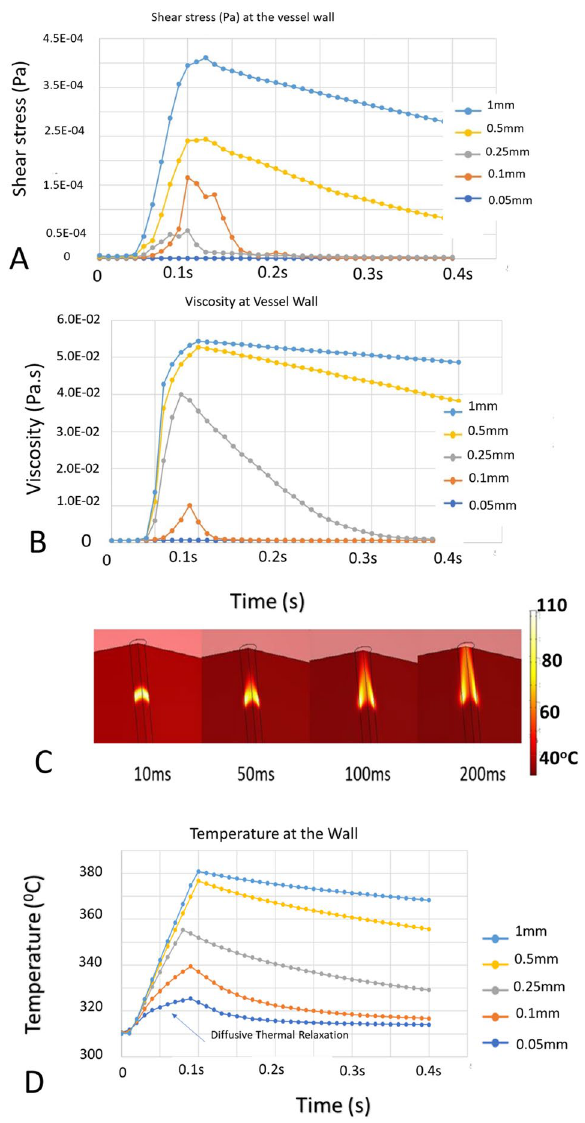
Figure 1. ( A ) Shear stress (Pa) at the vessel luminal wall for five blood vessel lumen diameters (0.05–1 mm) in response to pulsed laser (1.07 µm) irradiation (80 ms, 300 W average power). Shear stress increase is significantly higher post irradiation in the larger blood vessel case suggesting higher chances of coagulum breaking free from the wall as observed experimentally (Fig. 3). Irradiation is simulated as a flat top laser fluence from 0.05 to 0.1 s. ( B ) Viscosity (Pa.s) at the vessel luminal wall for five blood vessel sizes (0.05–1 mm) in response to pulsed laser (1.07 µm) irradiation (80 ms, 300 W average power). ( C ) Temperature profile within a blood vessel (1 mm diameter lumen) modified by blood flow dynamics (blood flowing from bottom to top). Heat at the walls persists while thermal energy is carried away at the center of the blood vessel. For large blood vessel diameters, heat transfer is dominated by blood flow over conduction. ( D ) Temperature relaxation observed during irradiation of smaller diameter blood vessels reduces viscosity whereas the viscosity in larger vessels remains elevated for longer times. The effect is consistent with an experimental result (Fig. 3, Panel C), just before the coagulum attached to the vessel wall is